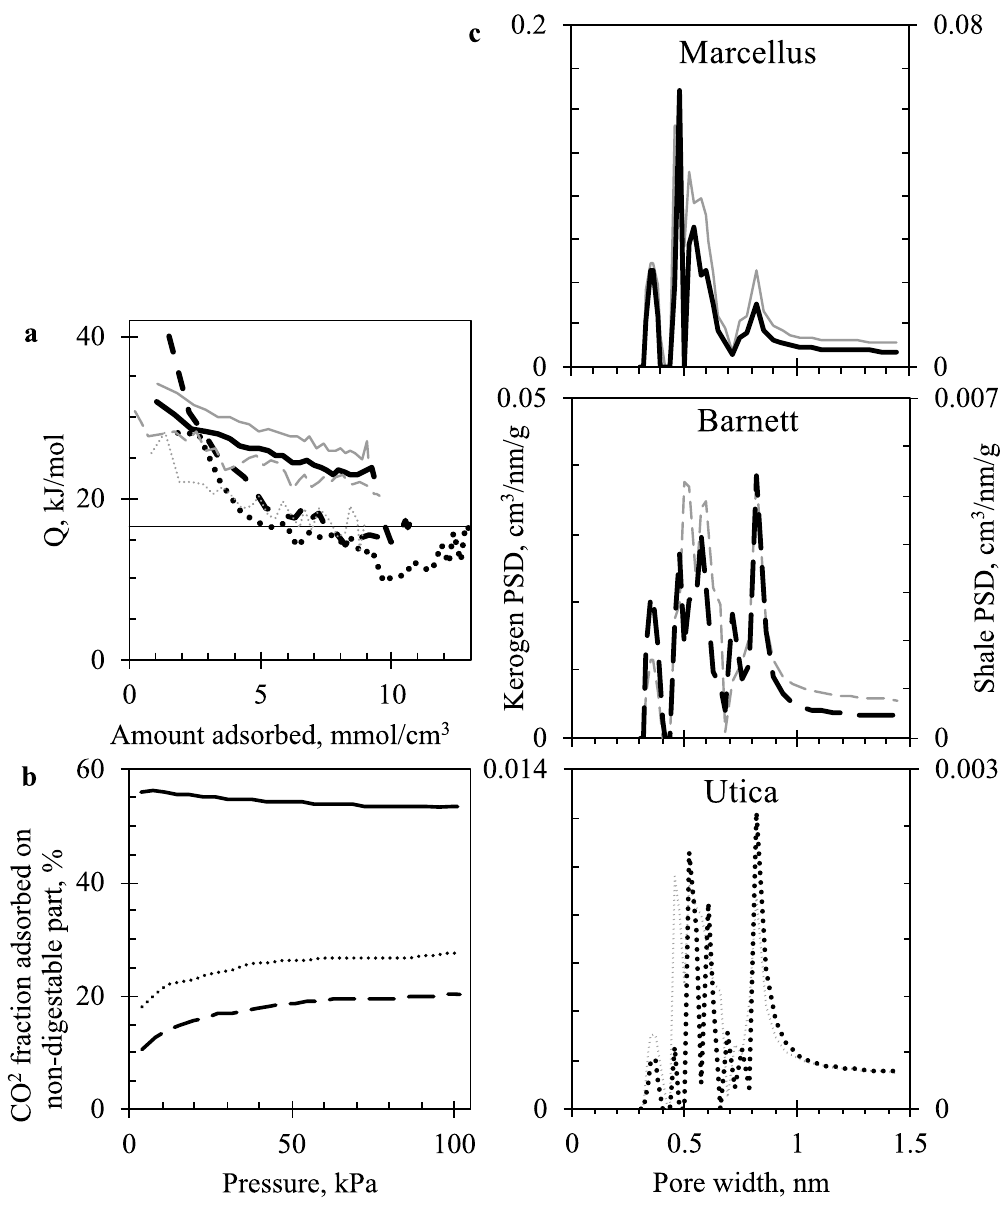
Figure 3. Heat of adsorption ( a ), fraction of CO 2 adsorbed on non-digestible part of shale ( b ) and micropore size distribution comparison between shales and kerogen-enriched shales ( c ) (black thick: — Marcellus, – – Barnett, ••• Utica, grey thin: kerogen-enriched